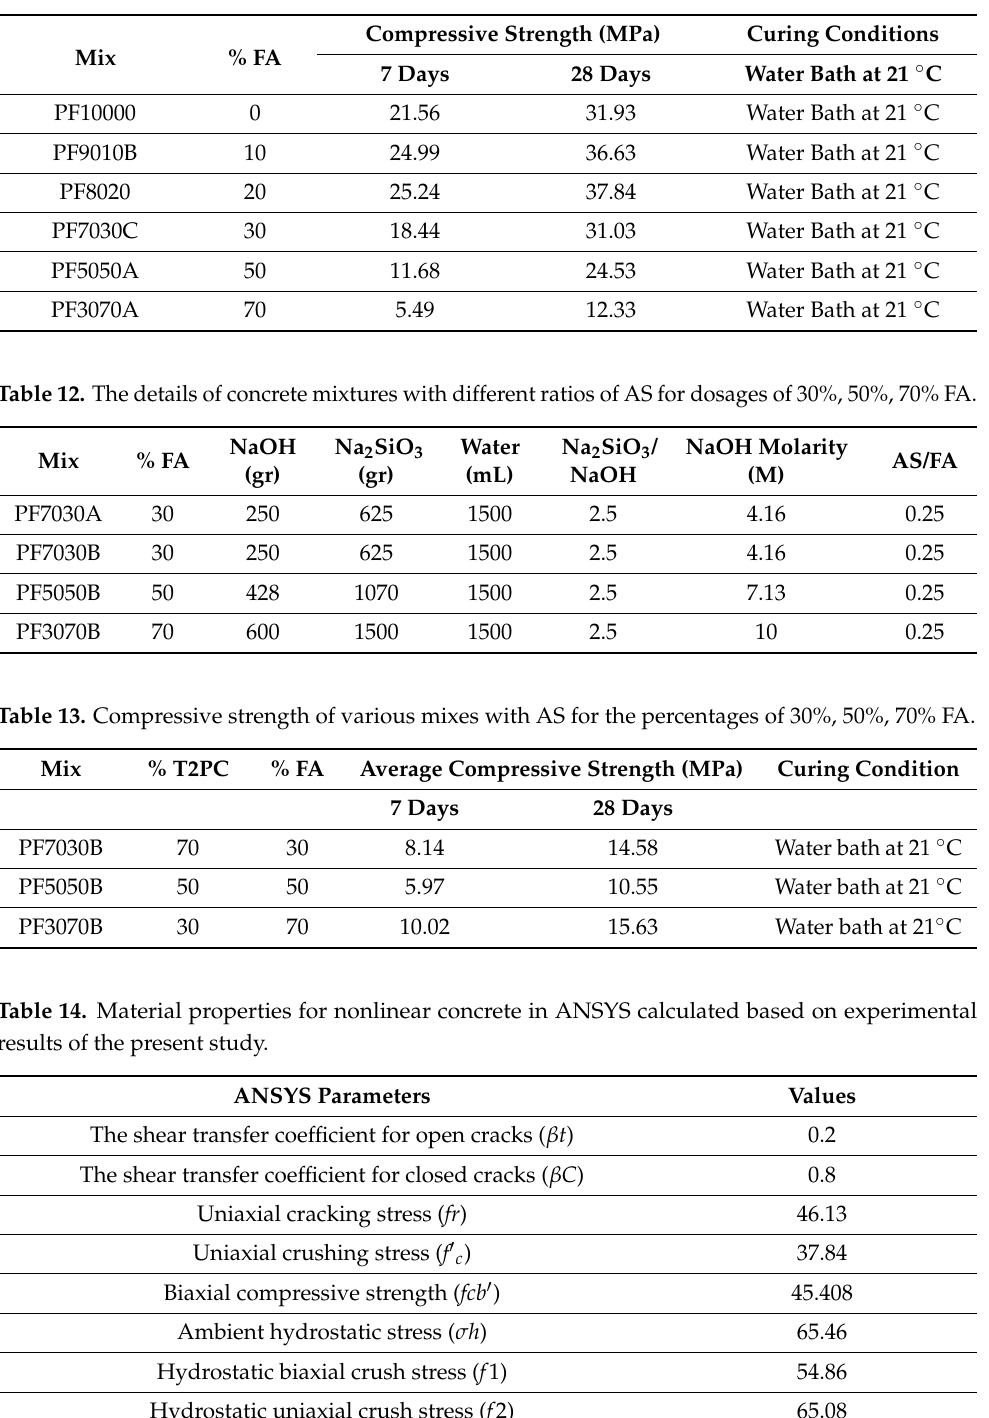
Table 11. Compressive strength of various mixes without alkaline solution (AS).